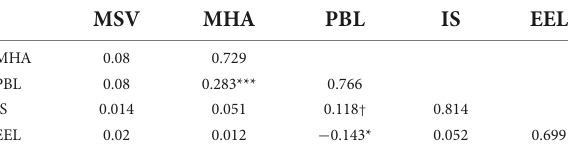
TABLE 3 Discriminant